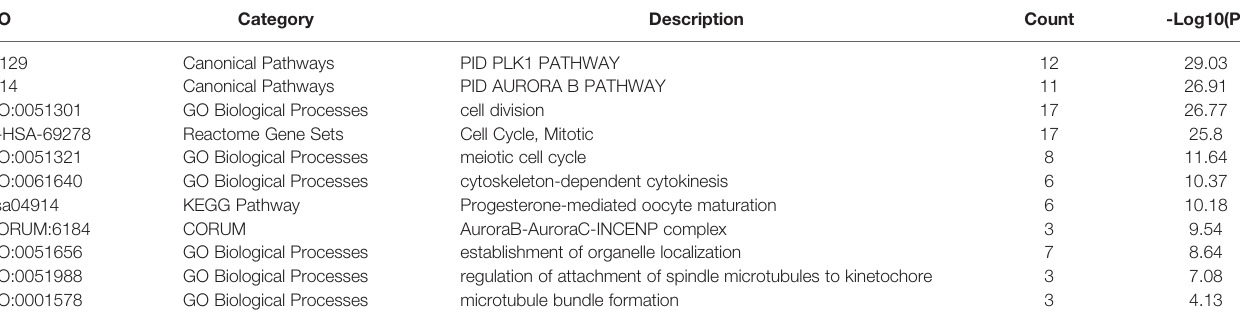
TABLE 2 | Pathway and process enrichment analysis of AURKA and top 20 interacting